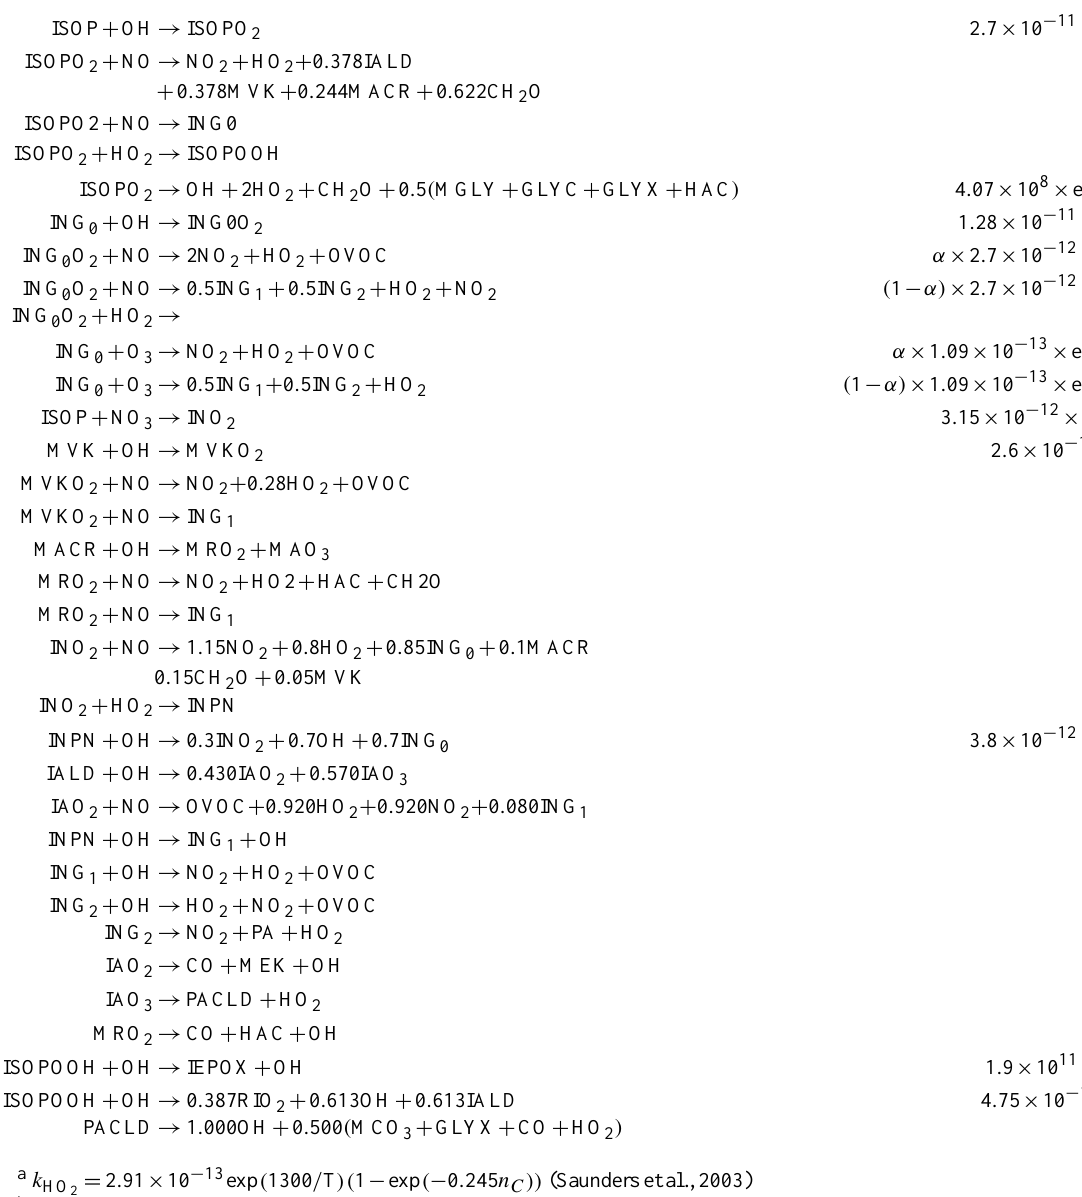
Table 1. Summary of the changes to the standard GEOS-Chem mechanism (Horowitz et al. (1998), see also http://acmg.seas.harvard.edu/ geos/wiki docs/chemistry/chemistry updates